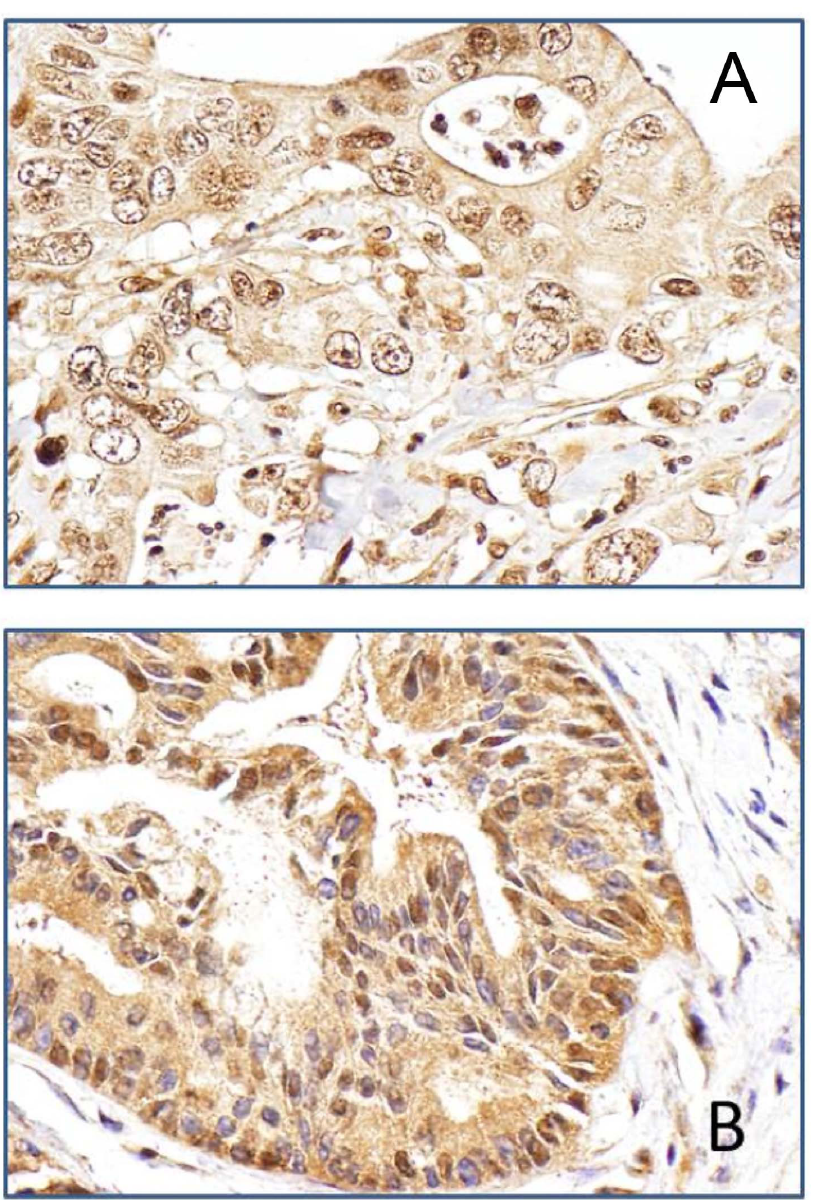
Figure 1. Typical Immunohistochemical staining pattern for TGF- b R2 and SMAD4 in pancreatic adenocarcinoma tumor tissues. A: Positive nuclear expression of TGF- b R2 in a moderately differentiated ductal adenocarcinoma of the pancreas (Magnification: 10 6 40). B: Positive nuclear expression of SMAD4 in moderately differentiated ductal adenocarcinoma of the pancreas (Magnification: 10 6 40).